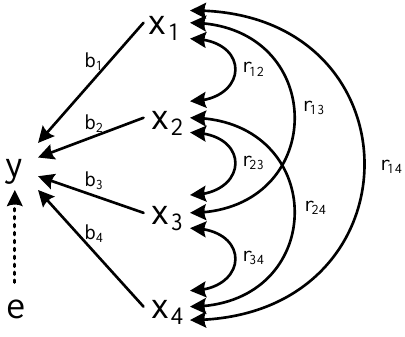
Figure 2. Path coefficient analysis. Note: x 1, x 2 , x 3 , x 4, e, y represent lignocellulose degradation, VFAs content, reducing sugar, pH, residual path coefficient, BMP, respectively.